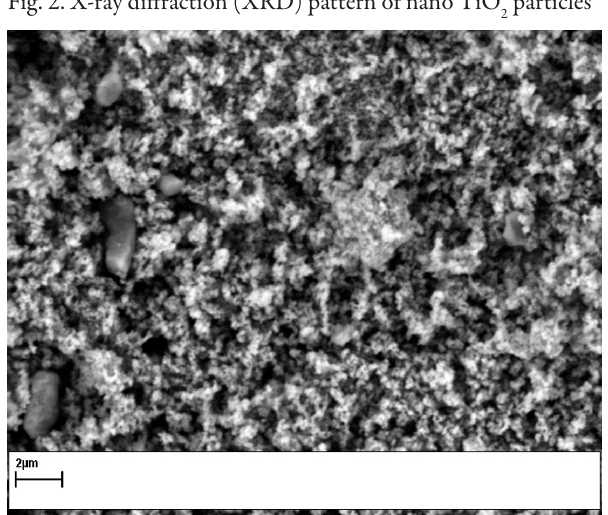
Fig. 2. X-ray diffraction (XRD) pattern of nano TiO